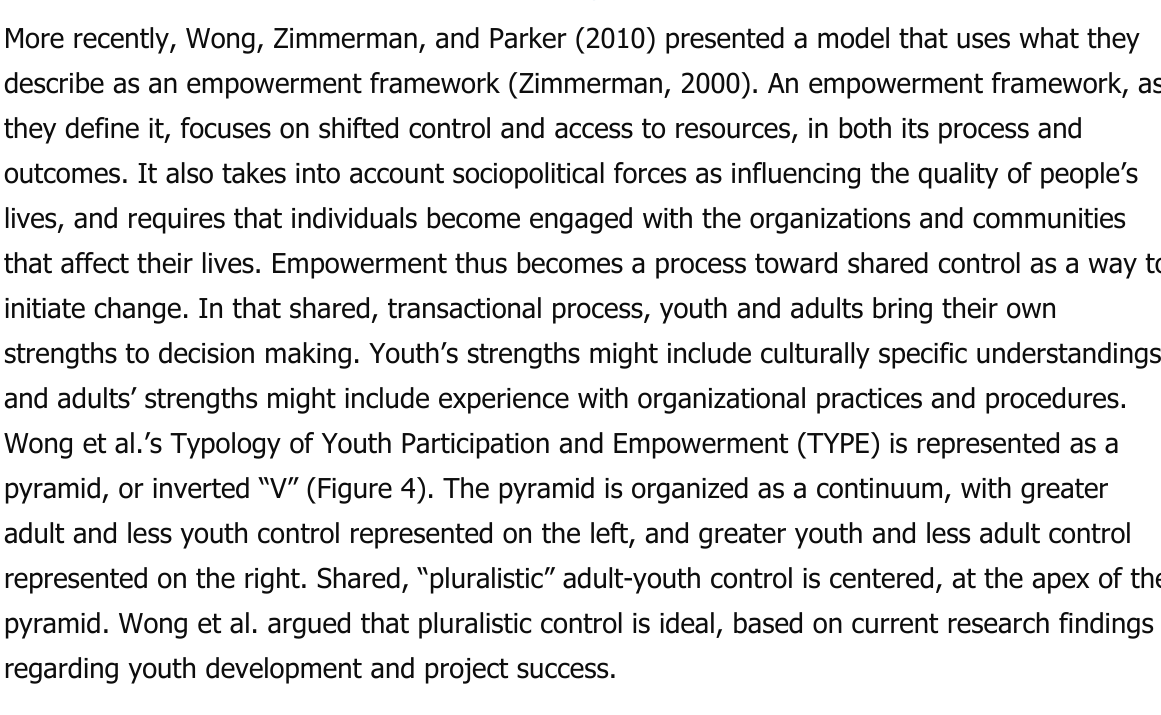
Figure 4. Wong et al.’s (2010) TYPE